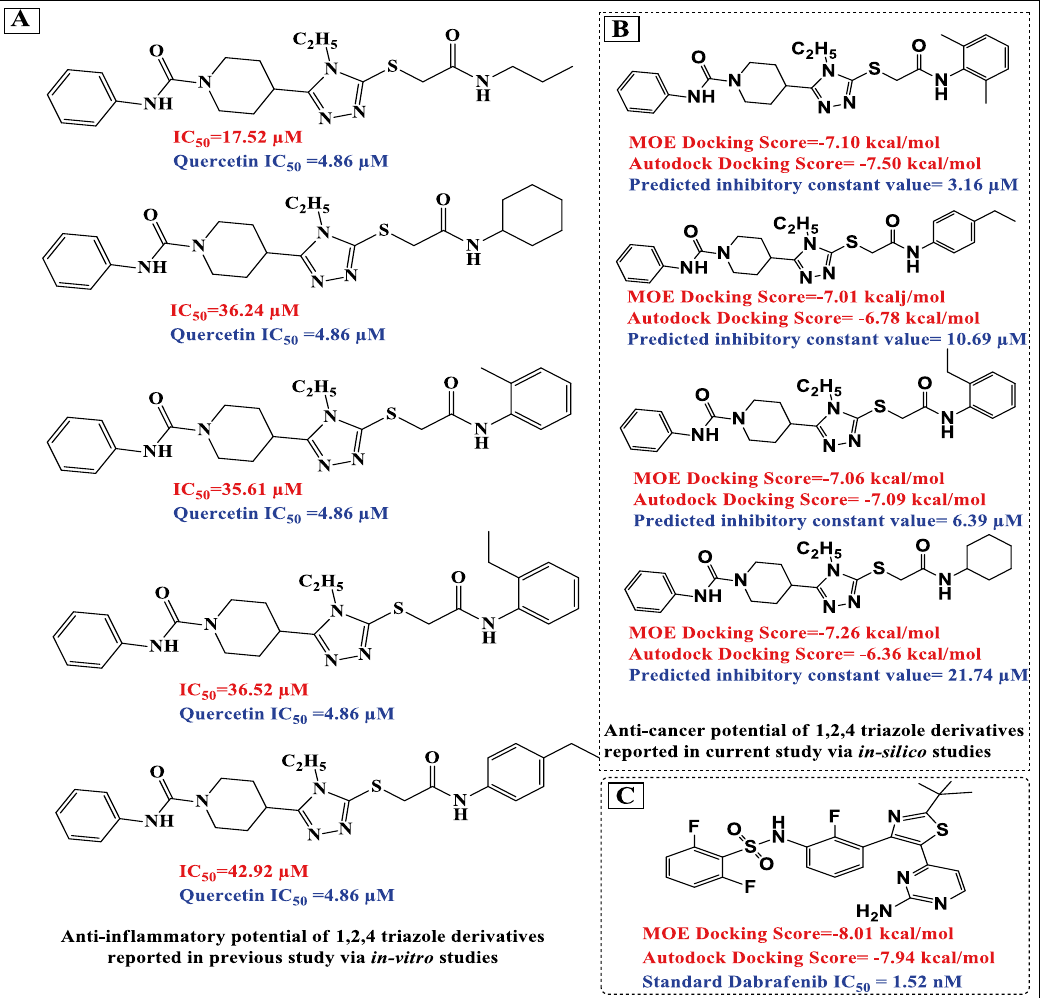
NEK7 ( C ) showing the Binding scores of Dabrafenib against NEK7: reported anti-cancer drug 38